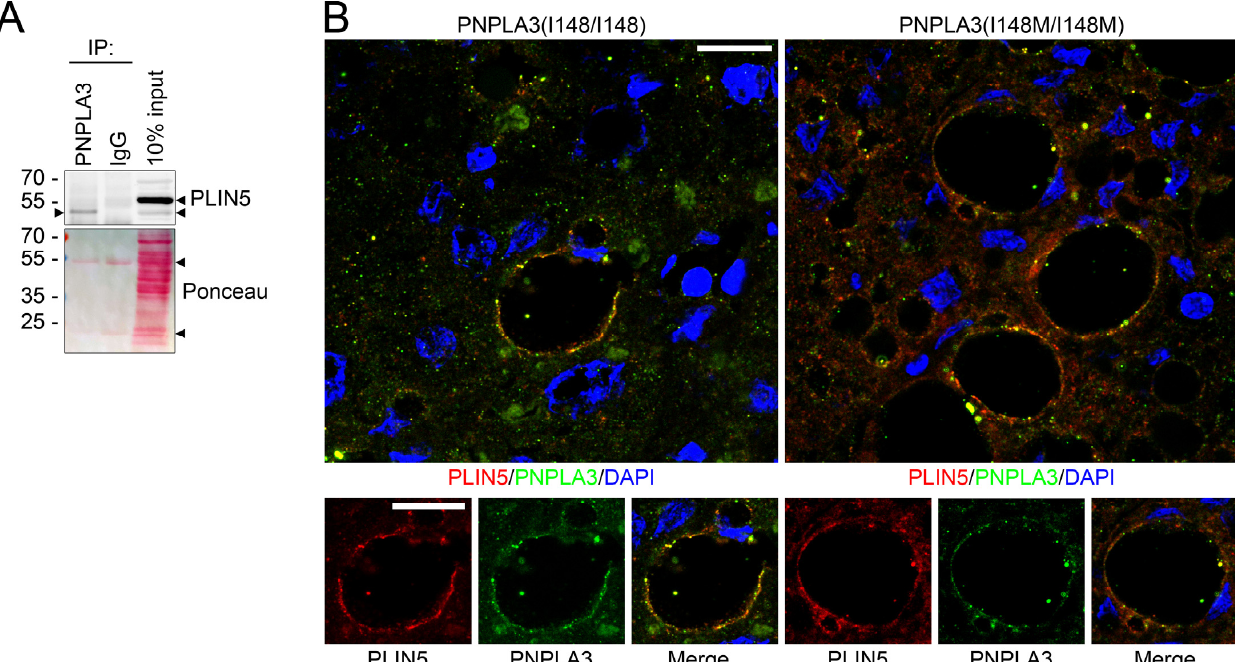
Figure A4. Validation of PLIN5-PNPLA3 complex formation in situ. ( A ) Immunoblot analysis of PLIN5 in co-immunoprecipitates performed with PNPLA3 antibody in post-nuclear lysates of human liver with PNPLA3(I148/I148). Only the lower migrating form of PLIN5 at approximately 52 kDa, but not the dominant full-length protein at approximately 55 kDa co-immunoprecipitates with PNPLA3. Ponceau staining of the same membrane shows that the same amount of antibody (PNPLA3, IgG) was used for IP. Arrows indicate the heavy and light chain of the antibodies. Molecular weight in kDa is given on the left. ( B ) Immunofluorescence microscopy of perilipin 5 (PLIN5, red) and PNPLA3 (green) of liver cryosections with different PNPLA3 status (nuclei: DAPI, blue). PLIN5 and PNPLA3 show colocalization at LDs. Scale bars: 15 µm.